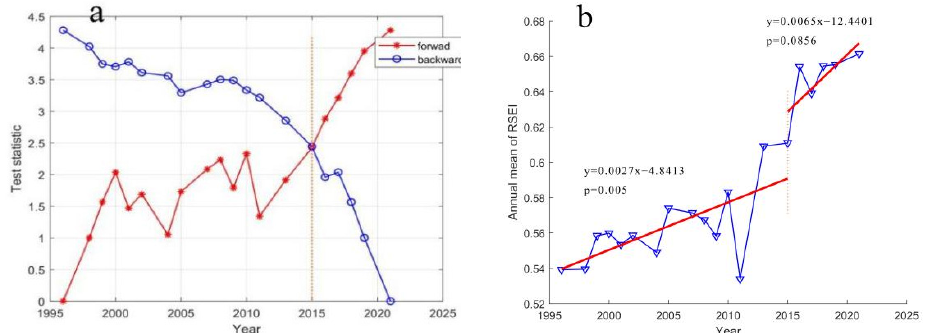
Figure 6. The potential turning point of the change of annual RSEI ( a ); RSEI inter-annual variations and linear trends for the two periods ( b ).